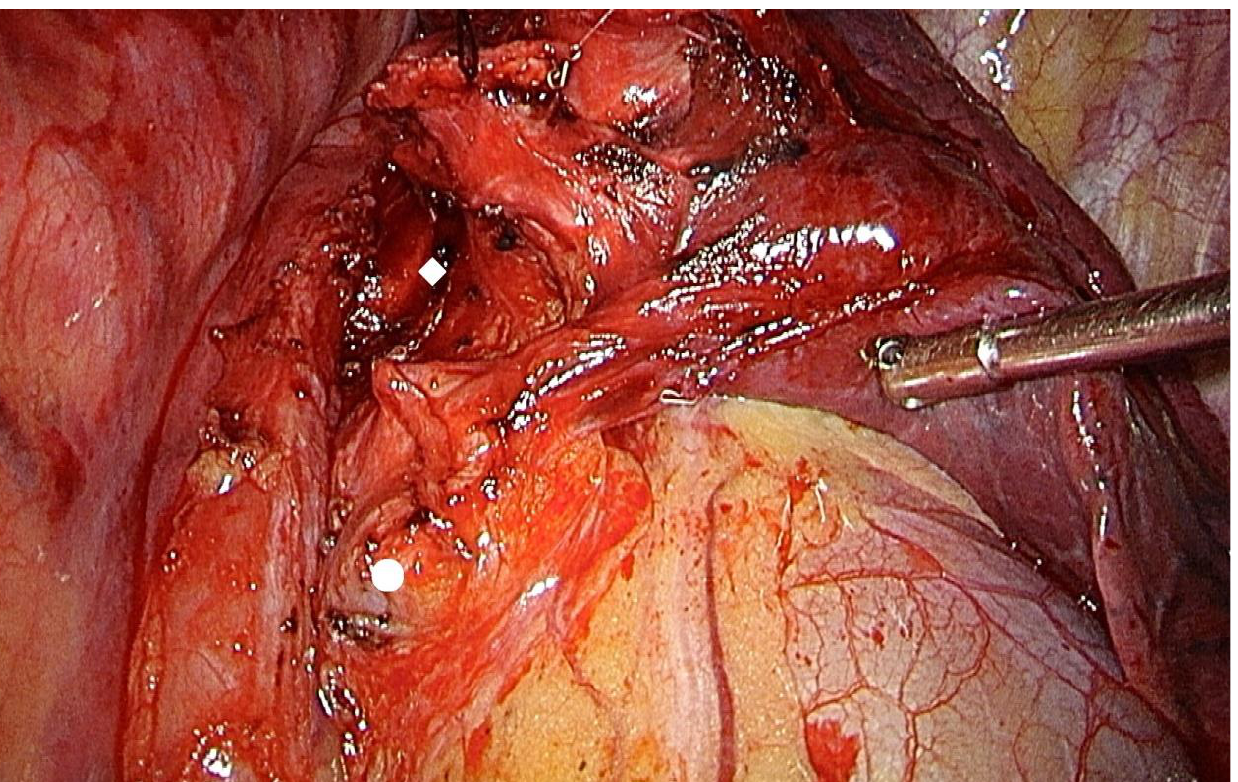
Figure 3. Lymph node station 5 and 6. Hexagon: station 5; asterisk: station 6. Subcarinal nodes are defined as station 7 (Figure 4), which is located from the carina of the trachea to the upper border of the lower lobe bronchus.